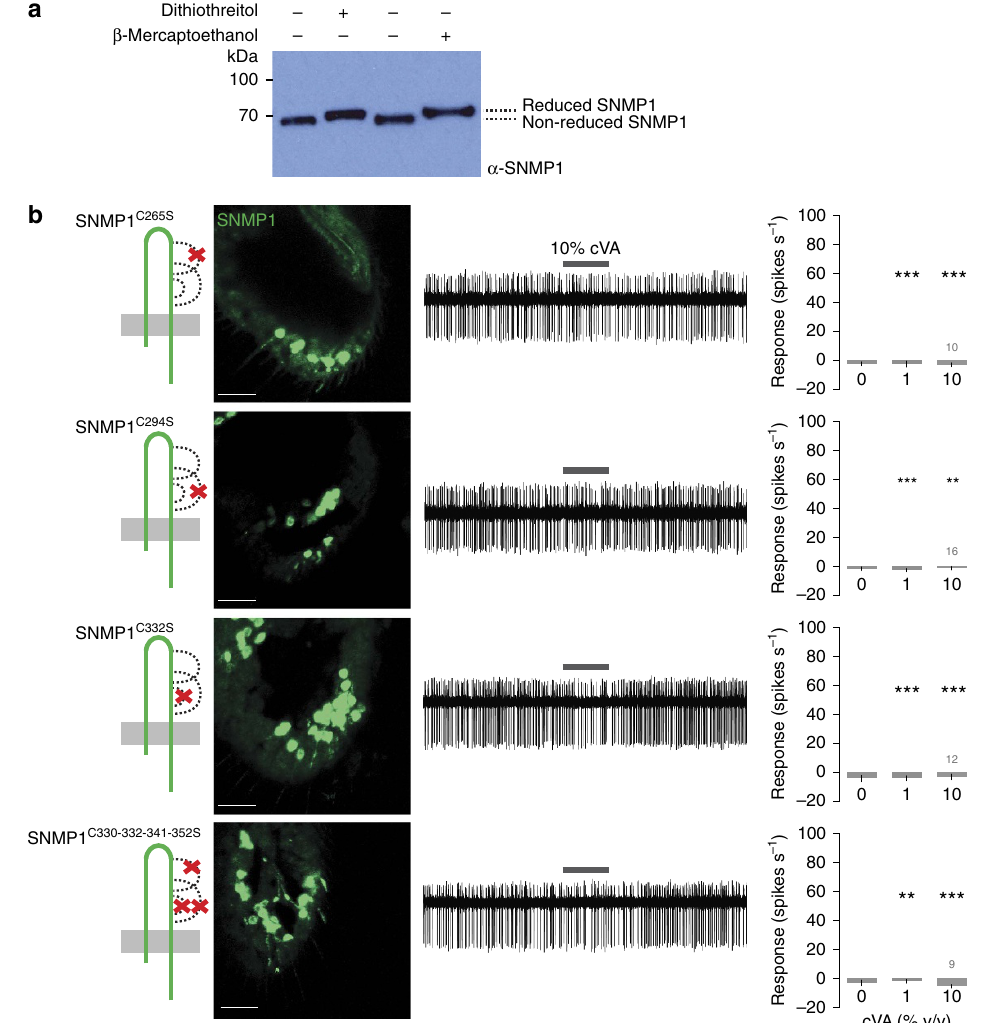
Figure 4 | Role of disulfide bridges in SNMP1 trafficking and function. ( a ) Analysis of the presence of intramolecular disulfide bonds in SNMP1 by electrophoretic mobility assay in non-reducing versus reducing conditions. Total antennal protein extracts were resolved by 4–20% SDS–PAGE in the presence or absence of the reducing agents dithiothreitol (100mM) or b -mercaptoethanol (10%). After western blotting, immunodetection was performed with a -SNMP1. ( b ) Analysis of the rescue properties of SNMP1 mutants lacking one or more disulfide-bond forming cysteine residues as indicated in the cartoons. Left: immunostaining with a -SNMP1 on antennal cryosections. Scale bars, 20 m m. Centre: representative traces of electrophysiological recordings of OR67d neurons in male flies stimulated with 10% cVA. Right: mean neuronal responses ± s.e.m. in each genotype. There are significant statistical differences in neuronal responses due to genotype for both 1 and 10% cVA (Kruskal–Wallis, P o 0.0001). Significant differences in cVA responses of the different genotypes compared with full-length SNMP1 rescue (Fig. 5) are indicated in the figure; ** P o 0.01, *** P o